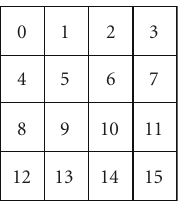
Figure 1: 4 × 4 block transform 16 coe ffi cients